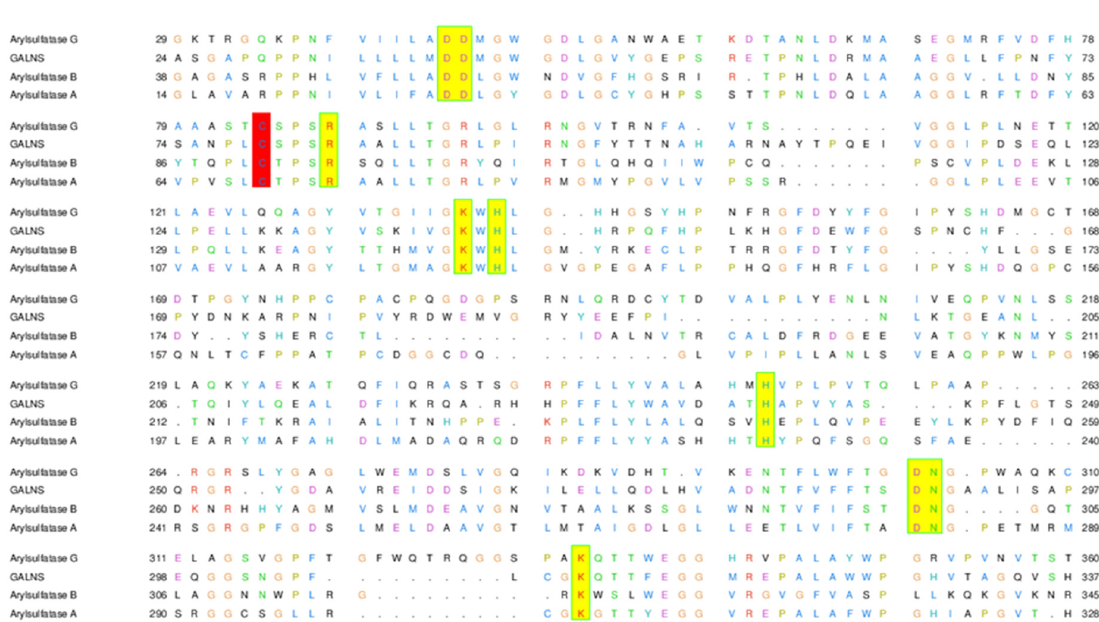
Figure 3. Sequence alignment of ARSG. GALNS template for homology modeling and two representatives of arylsulfatase family ARSB and ARSA. Cysteine modified to formylglycine is marked in red; other conserved amino acids are in yellow.